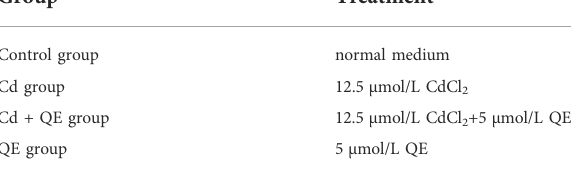
TABLE 1 Treatment of cells.